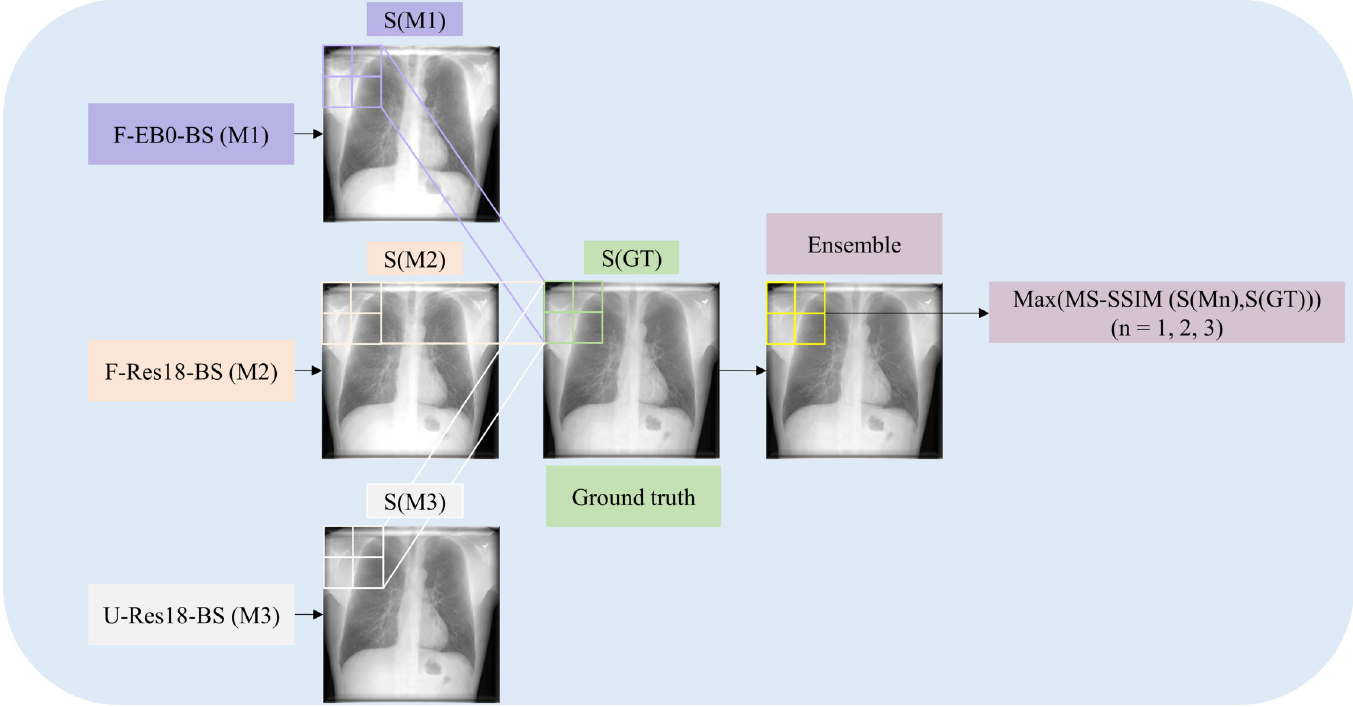
Fig 5. The architecture of the proposed